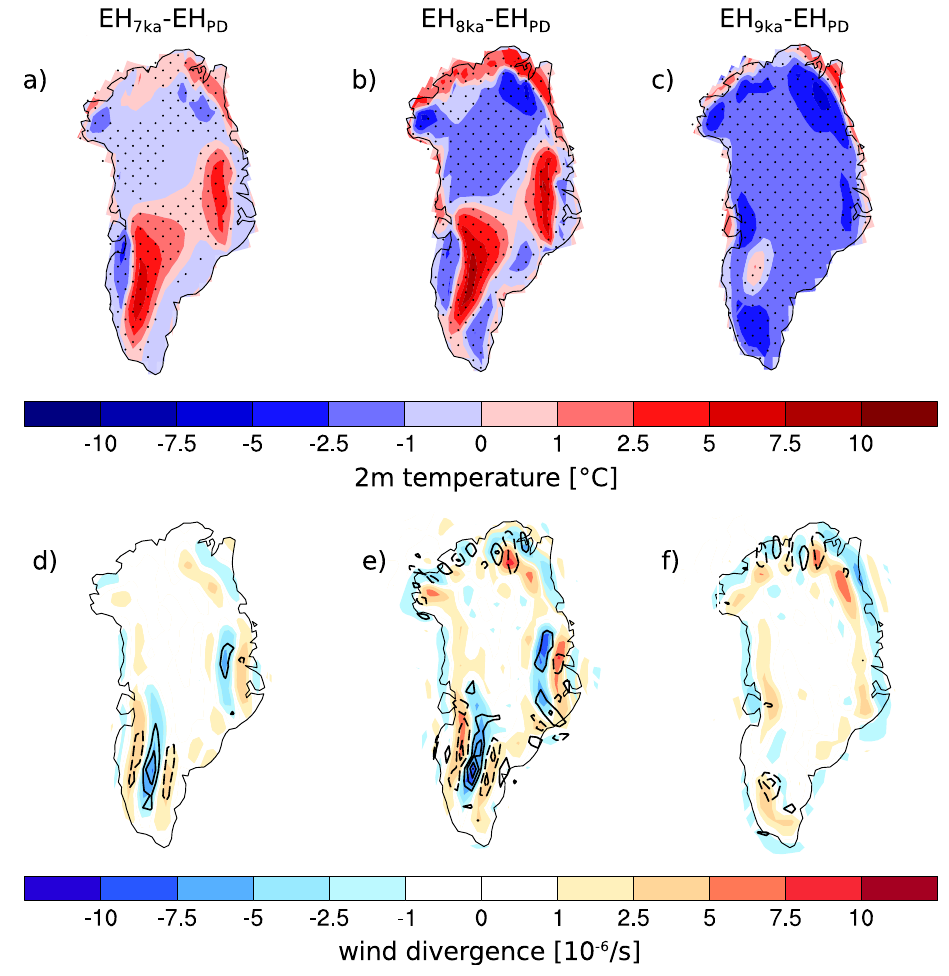
Fig. 6. Early Holocene ice sheet sensitivity of annual mean (a, b, c) 2m temperature [ ◦ C] and (d, e, f) wind divergence [10 − 6 s − 1 ] over the Greenland Ice Sheet for the simulations with 7, 8 and 9ka ice sheet topography. All values are anomalies from the basic early Holocene simulation (EH PD ) with present-day Greenland Ice Sheet. Stippling in (a, b, c) denotes values significant at the 5% level based on t -test statistics. In (d, e, f) the shading denotes wind divergence at 850hPa and contour lines represent wind divergence at 500hPa with negative contours stippled and no zero line shown. Areas with negative (positive) wind divergence at the surface (at higher levels) experience local upward flow. Vice versa, areas with positive (negative) wind divergence at the surface (at higher levels) experience local downward